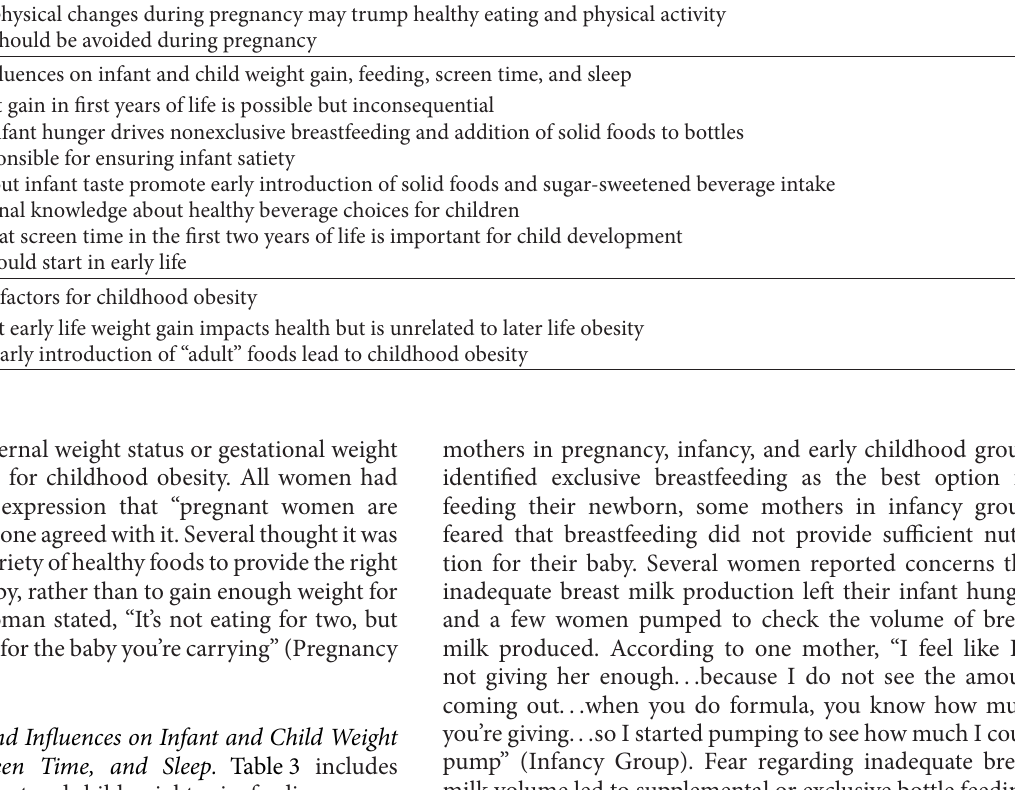
Table 3: Themes related to weight gain and obesity risk factors in pregnancy, infancy, and early childhood among Hispanic women. ( 𝑛 = 49 ). Beliefs and perceptions of pregnancy